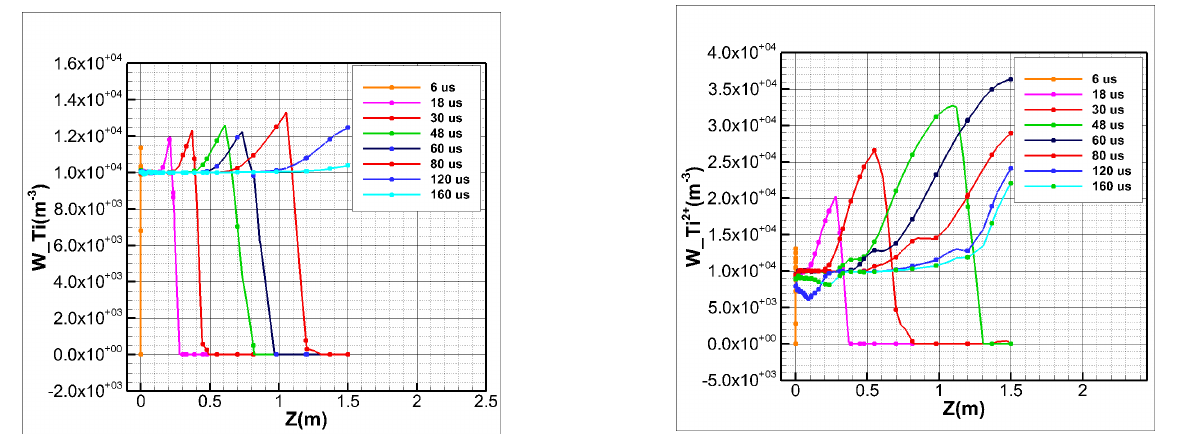
Figure 9. Variation curves of the atomic Ti and Ti 2+ velocities along the z-direction at various times along the symmetry axis.